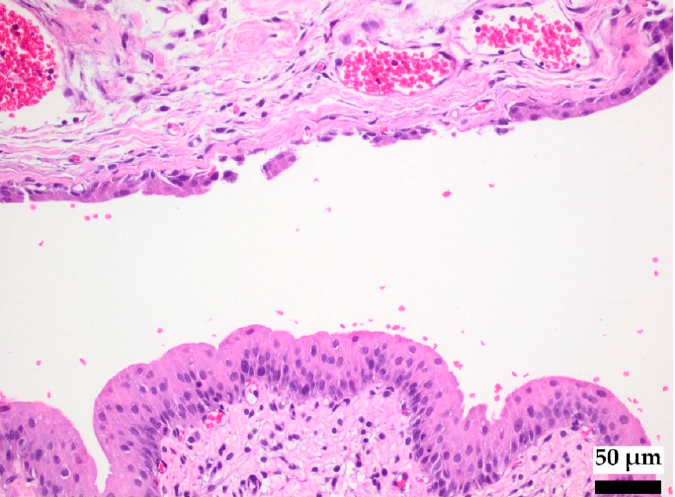
Figure 5. Protamine-damaged urothelium of the urinary bladder in the rat, shown by HE staining.